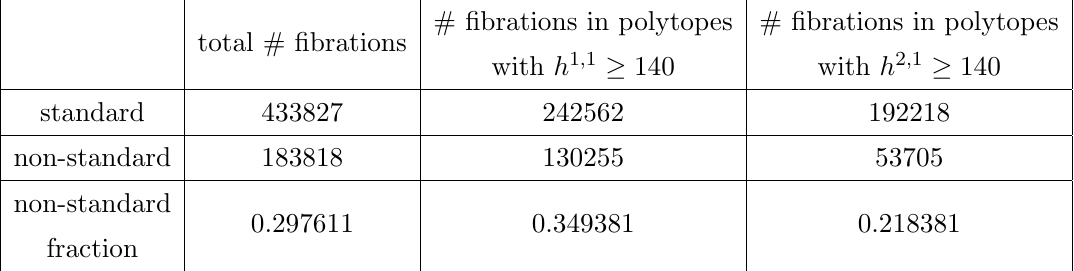
Table 6 . Fractions of (cid:12)brations by the (cid:12)ber F 10 that take the \standard stacking" form versus other